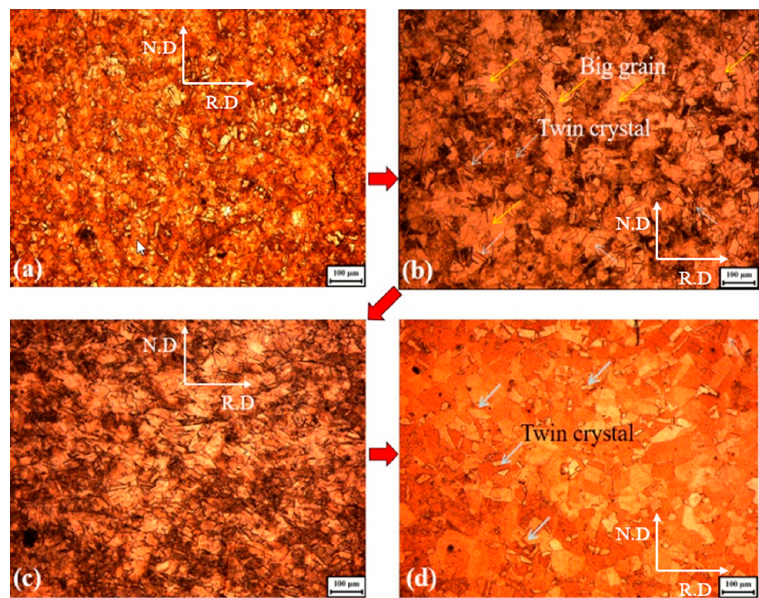
Figure 3. Microstructural evolution of copper at four different stages: ( a ) raw material, ( b ) sample after annealing at 600 °C for 12 hours, ( c ) sample after re-cold rolling, and ( d ) sample after re-annealing at 600 °C for 12 hours. (N.D is the normal direction and R.D is the rolling direction).